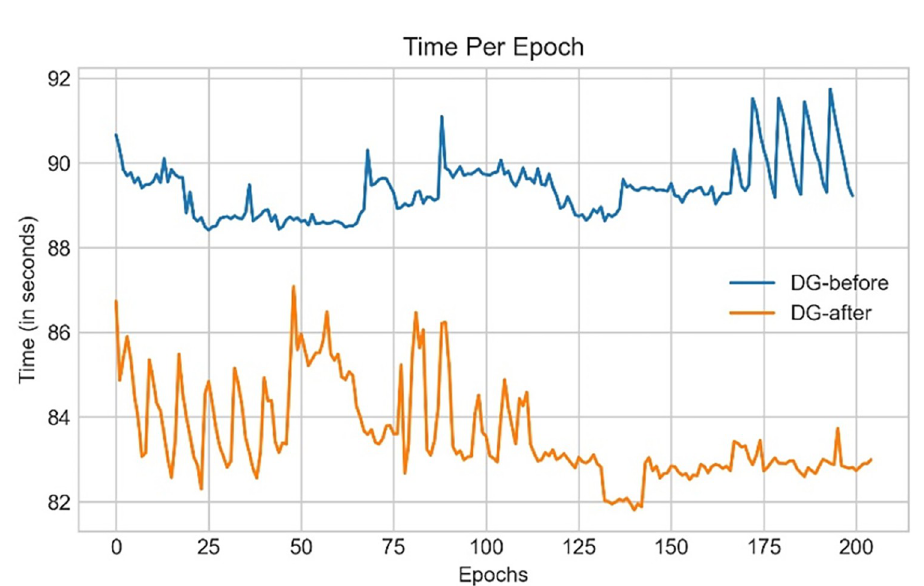
Fig 29. Training time per epoch comparison for 200 epochs of datasets ‘DG-before’ and ‘DG-after’ where ‘DG- before’ indicates the dataset before applying downscaling and ‘DG-after’ indicates the dataset generated after down-scaling. Another impact, observed during training is that our down-scaled dataset (DG-after) records the highest accuracy within 200 epochs (Fig 30) whereas the non-down-scaled dataset (DG-before) takes more than 200 epochs to achieve the highest accuracy. This further adds to the efficiency of employing this method on future